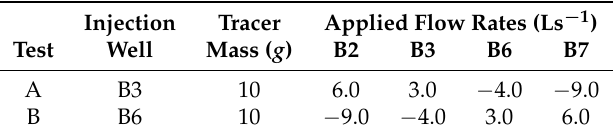
Table 1. Settings of the groundwater flow and transport simulations. Negative flow rates denote extraction of water, whereas positive numbers refer to the injection of